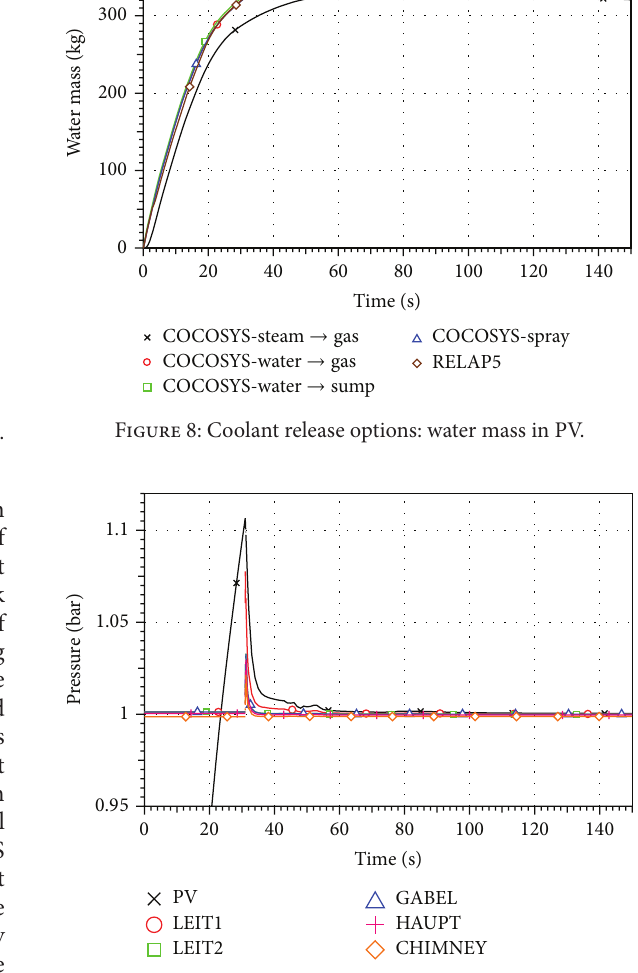
Figure 9: Base case scenario: pressure in the